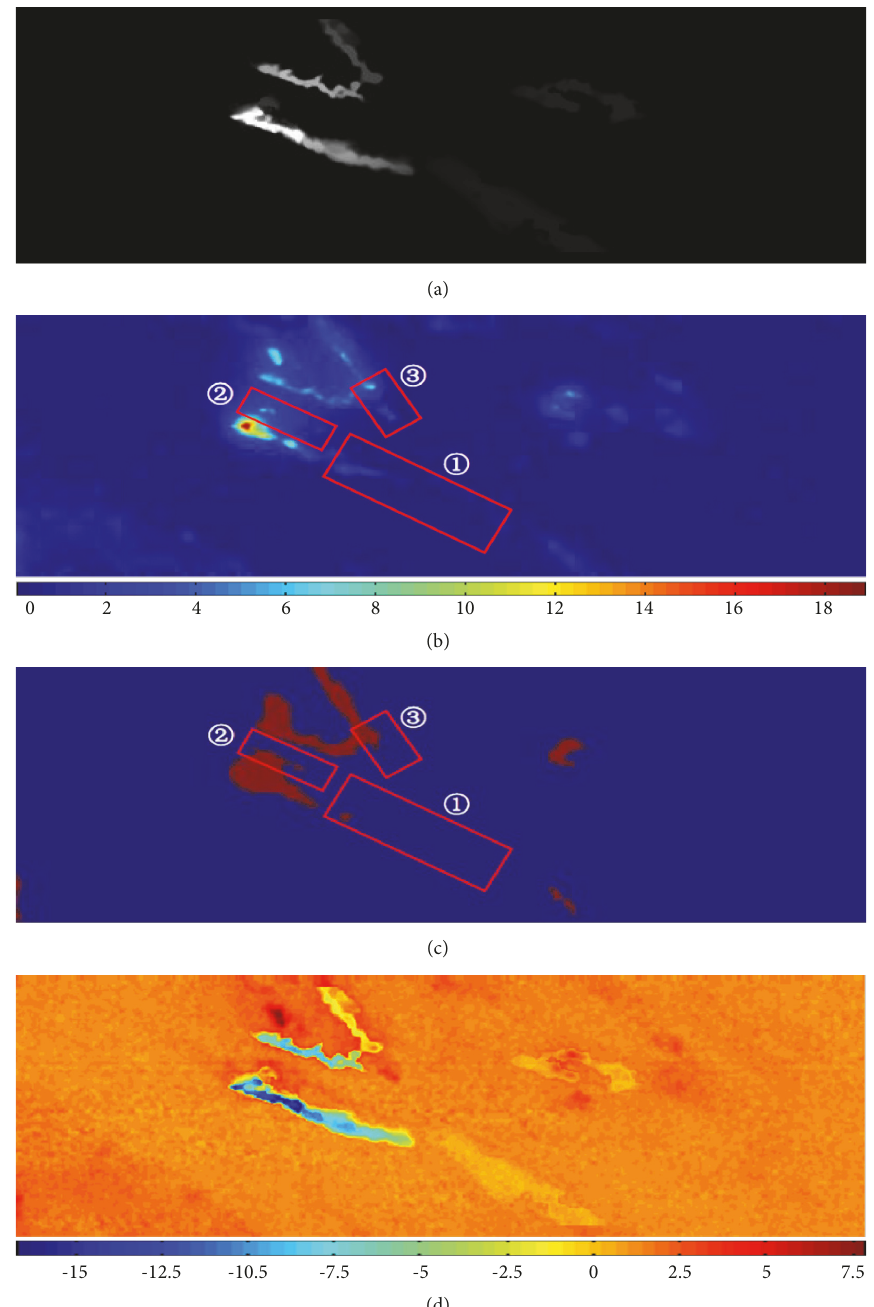
Figure 9: Extraction results using the getfilaments algorithm. (a) Extracted filament. Part of information is removed, including noises and structures.(b)Extractedfilamentwithcolorsforcontrast.Structuresofthefilamentarecleanedinthreemarkedplaces.(c)Contourextraction of the filament. (d) Residuals after the subtraction of the extracted filament from the original input